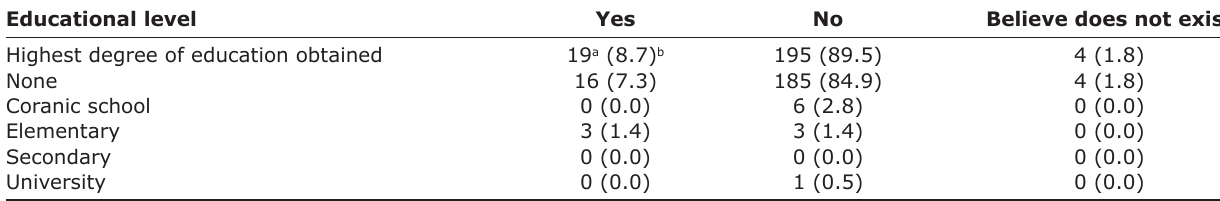
Table-1: Distribution of the educational level of shepherds according to knowledge about the definition of a